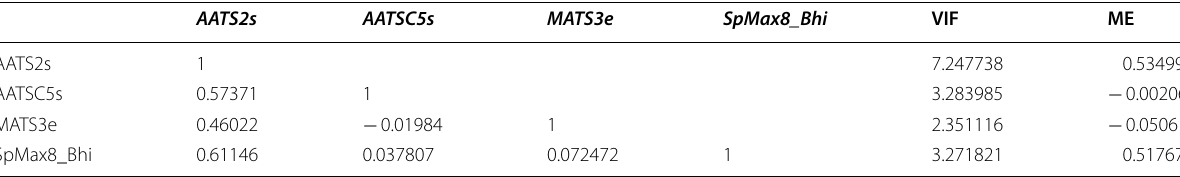
Table 4 Pearson correlation matrix, VIF and ME of the selected